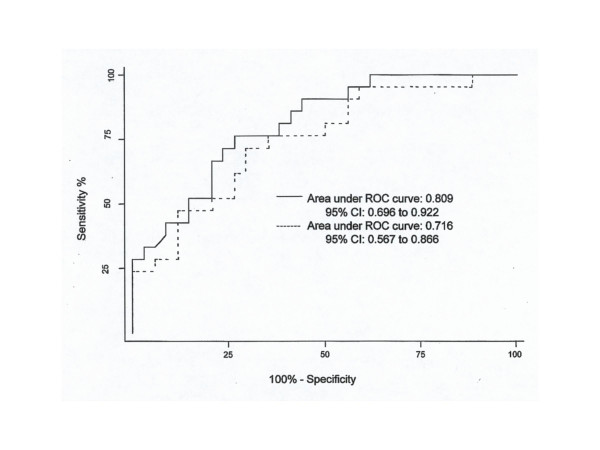
The receiver-operating characteristics (ROC) curves are shown for V,NEP0.5  values during NEP (-5 cmH2O) both in supine (continuous line) and seated  (dashed line) position in 34 patients with OSAH and 21 subjects without  OSAH. The area under the ROC curves reflects the ability of V,NEP0.5 to  distinguish subjects without and with OSAH (AHI>5).